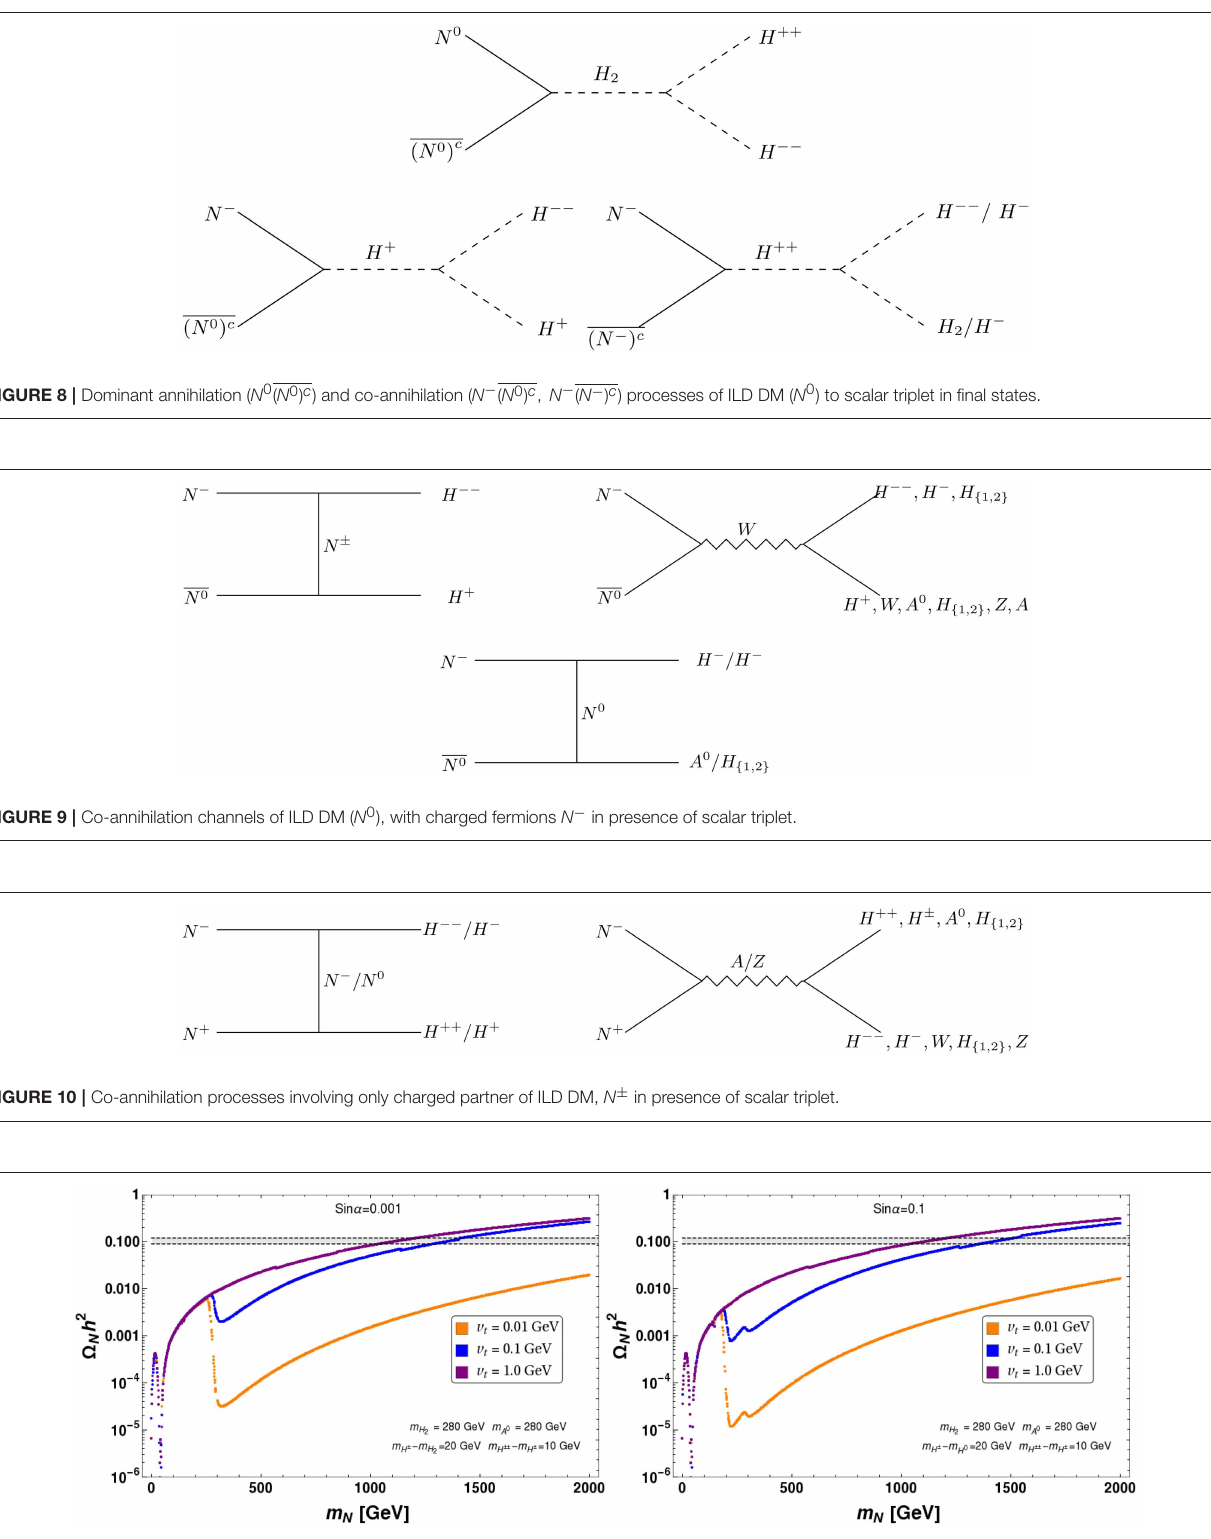
0.001 (left) and sin α 0.1 (right) . Others parameters are mentioned in = = =